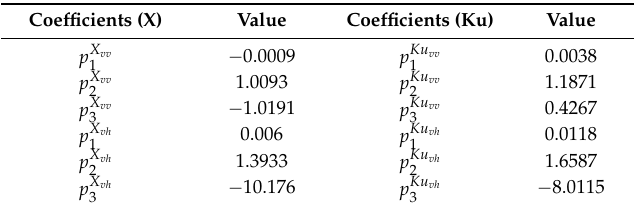
Table 4. Coefficients for Snow Volume Scattering Parameterization.